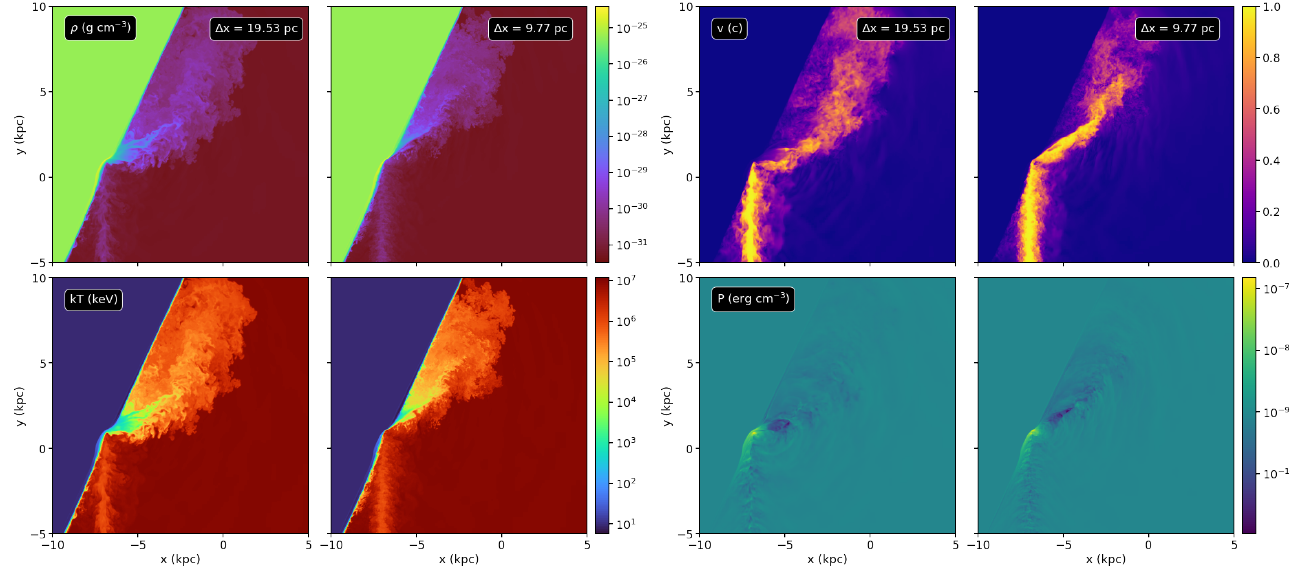
Figure A1. Comparison of the fiducial simulation at two different spatial resolutions at t = 125 kyr. ( Left panels) Slices through the center of the simulation domain of density and temperature. ( Right panels) Slices of velocity magnitude and pressure. Each panel is 15 kpc on a side, zoomed in slightly to focus on the parts of the simulation most affected by the